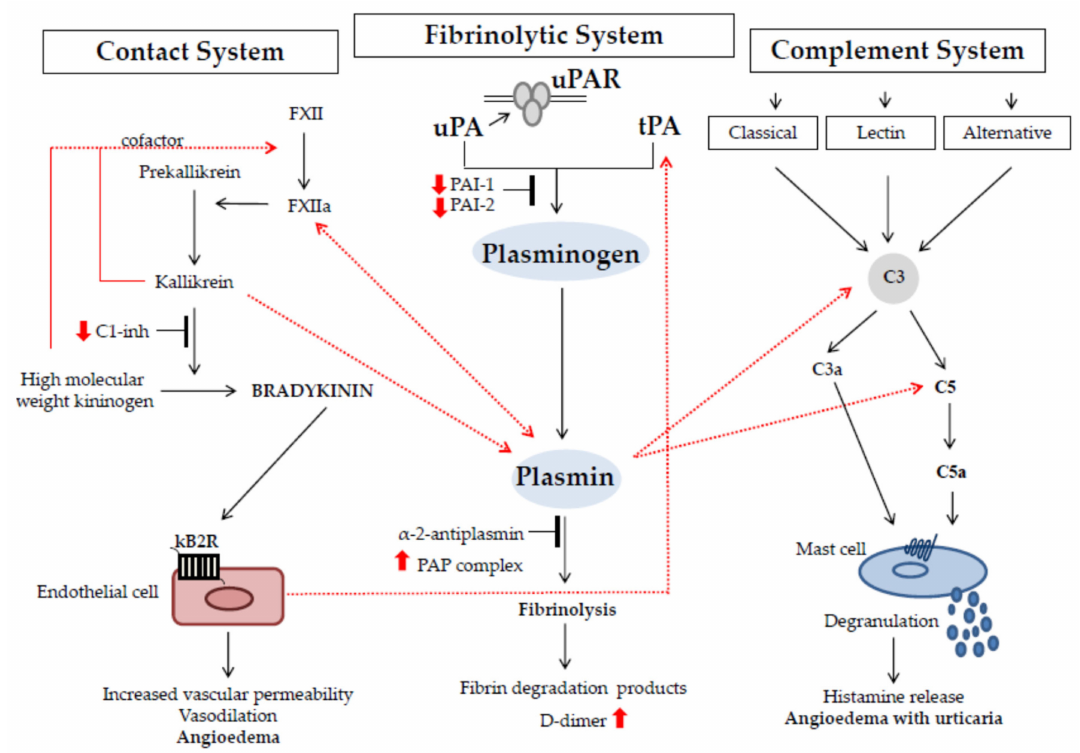
Figure 2. Links between the fibrinolytic system, the contact system, and the coagulation system in AE pathogenesis. The figure shows the complex multiple relationships that modulate the interplay of the molecules belonging to the fibrinolytic system. The red, dashed arrows indicate the contacts between the molecular pathways, while the red arrows indicate the increase or decrease of molecules in the plasma from patients affected by angioedema disease (AE). The interaction between the fibrinolytic system and the contact system leads to an auto-amplification loop that sustains the generation of bradykinin, the main mediator of AE attacks. Plasmin is also able to activate the classical pathway of complement and to cleave C3 and C5, generating C3a and C5a, respectively. The anaphylatoxins C3a and C5a induce mast cells’ degranulation and inflammatory mediators’ release. The most important preformed mediator is histamine, which mediates allergic forms of